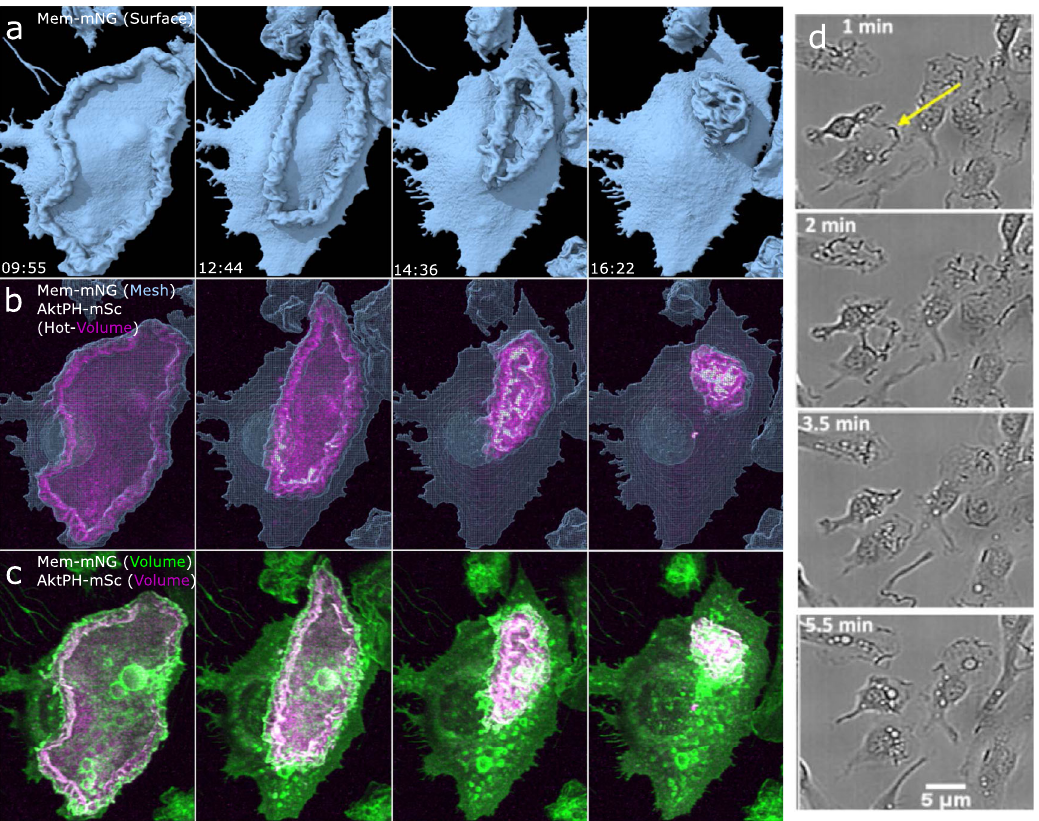
Fig. 6 Growth factor starvation and stimulation results in the formation of large circular dorsal ruf fl es that corrals PIP 3 /PIP 2 . Macrophages were starved of CSF-1 for 24 h, imaged for 5 min as a baseline, and imaging restarted 1 min after stimulation with CSF-1. Four-frame montages provide a visual display of the large dorsal ruf fl e that acts as a diffusional barrier that restricts PIP 3 /PIP 2 to the inside of the ruf fl e as it is cleared from the surface. This barrier is likely acting as a signal ampli fi cation mechanism stimulating the production of many macropinosomes. a Isosurface rendering provides crisp surface directionality; b surface mesh and volumetric AktPH-mSc (magenta hot) show the restricted probe as the membrane converges. c Volumetric intensity of both Mem-mNG and AktPH-mSc show the intensity locations of the membrane ruf fl e and the restricted AktPH (49 × 60 µ m x , y ). d Bright fi eld images showing multiple cells responding to stimulation with similar dorsal membrane